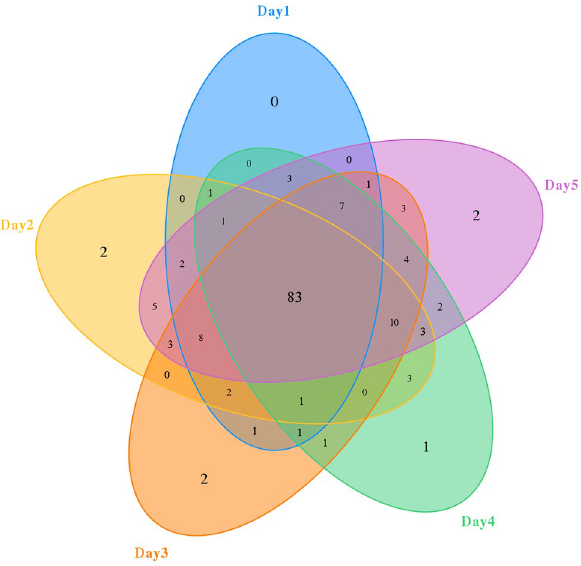
Figure 1. A Venn diagram of the bacterial OTUs in Chrysomya megacephala pupa at different developmental stages. Numbers within the compartments indicate OTU counts based on mathematical sets. OTU, operational taxonomic unit.